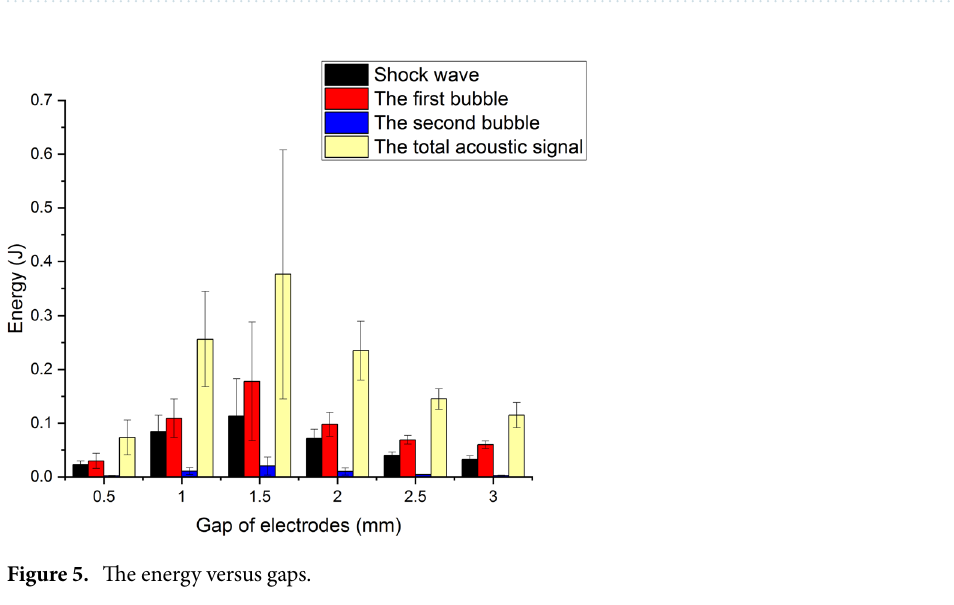
Figure 4. The peak pressure versus gaps.